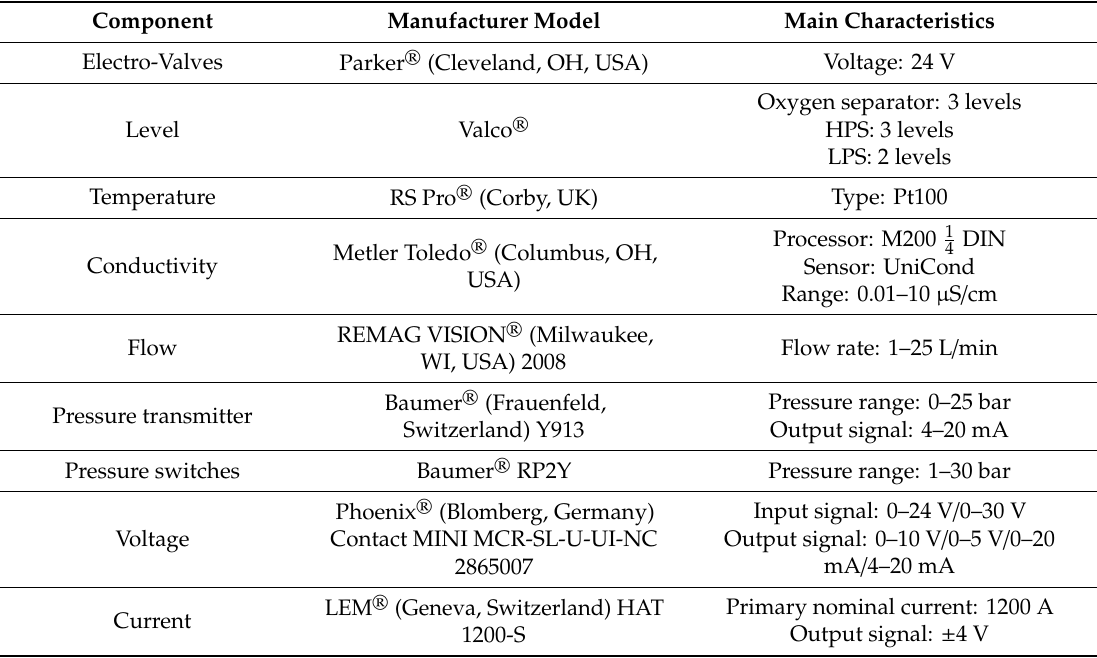
Table 4. Sensors and actuators technical characteristics.